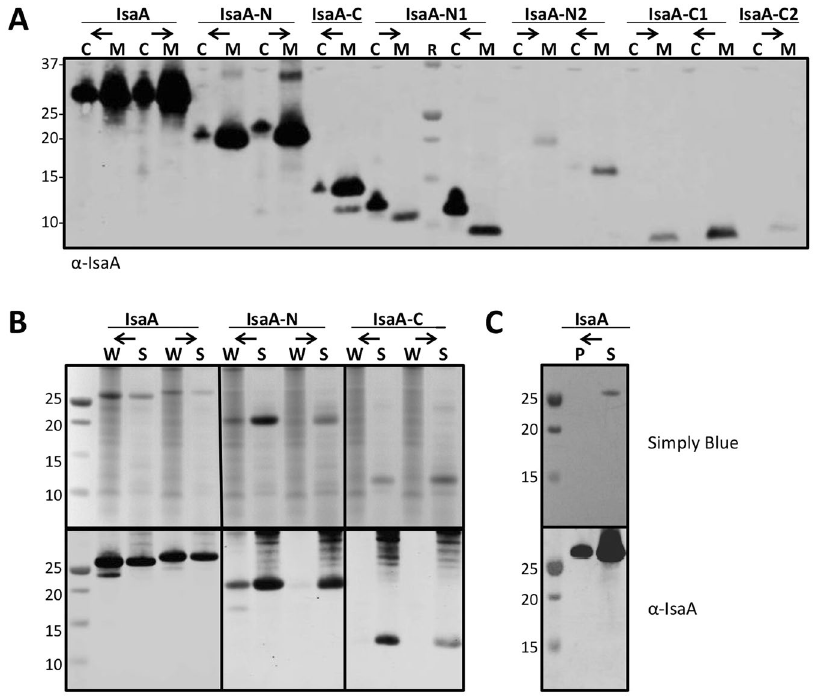
Figure 4. Cell wall association of IsaA-derived protein fragments. ( A ) IsaA, its N-terminal (IsaA-N, IsaA-N1, IsaA-N2) and C-terminal (IsaA-C, IsaA-C1, IsaA-C2) fragments were expressed in L . lactis PA1001 with the Usp45 signal peptide for export from the cytoplasm and an N-terminal ( ← ) or C-terminal ( → ) His-tag (see Fig. 1B). Next, cells (C) were separated from the growth medium (M) by centrifugation and the presence of full- size IsaA or its fragments in the respective fractions was analyzed by Western blotting using α -IsaA polyclonal rabbit antibodies. ( B ) The rebinding potential of secreted IsaA or IsaA-derived fragments to the S . aureus cell wall was assessed using full-size IsaA or IsaA-derived fragments (as described in A ) and crude cell wall extracts from S . aureus MA12 Δ isa A as described in the Materials and Methods section. Upon incubation for 10 min, the cell walls were pelleted by centrifugation and proteins in the pelleted cell wall (W) and supernatant (S) fractions were analyzed by LDS-PAGE and Simply blue staining (upper panels) or Western blotting using α -IsaA polyclonal rabbit antibodies (lower panels). ( C ) As a control, IsaA was incubated without the crude cell wall extract from S . aureus MA12 Δ isaA and upon incubation centrifuged. Pellet and supernatant fractions were processed as described in ( B ). The molecular weights (kDa) of marker proteins are indicated on the left.